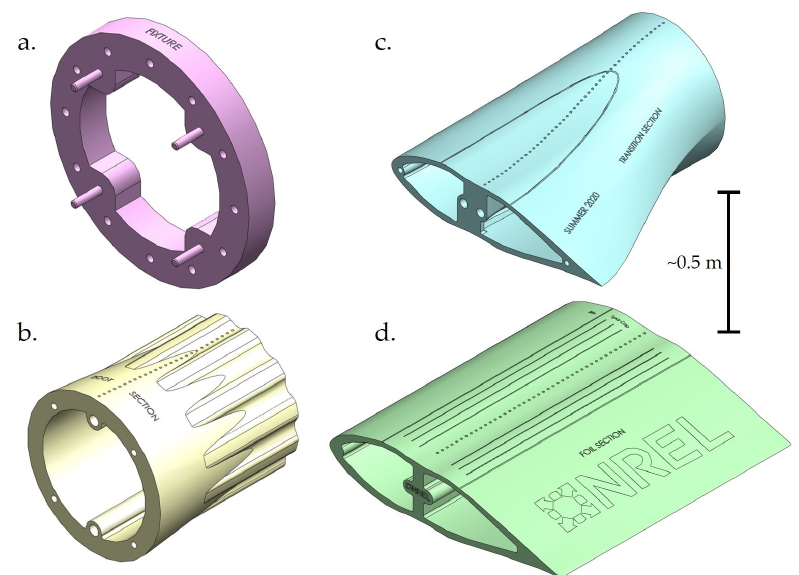
Figure 4. Models of the four mold sections to be printed for the conceptual tidal turbine blade section design where ( a ) is the sacrificial root fixture, ( b ) is the root section, ( c ) is the transition section, and ( d ) is the main hydrofoil section.